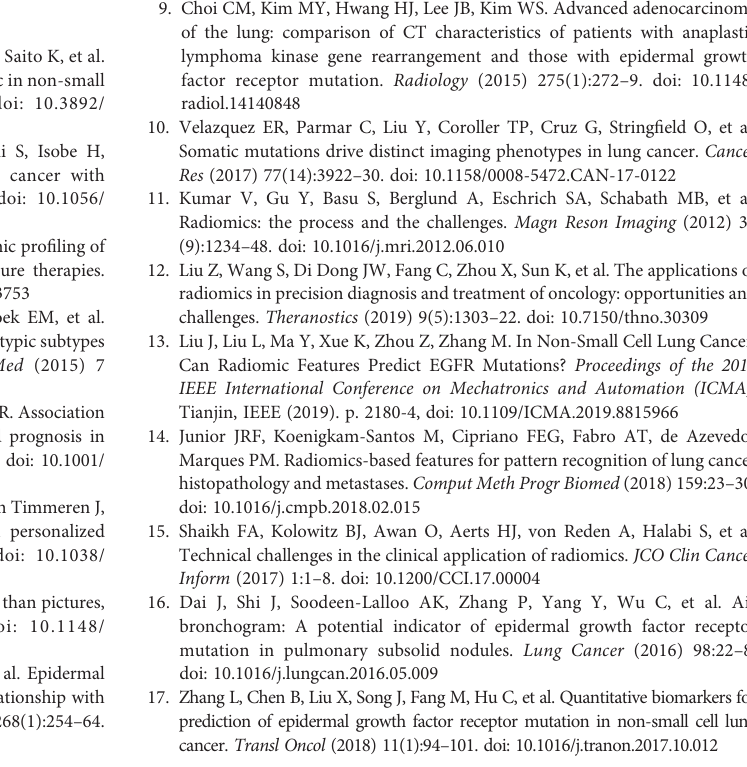
Supplementary Figure1 | The architecture and parameter settings of 1D-CNN